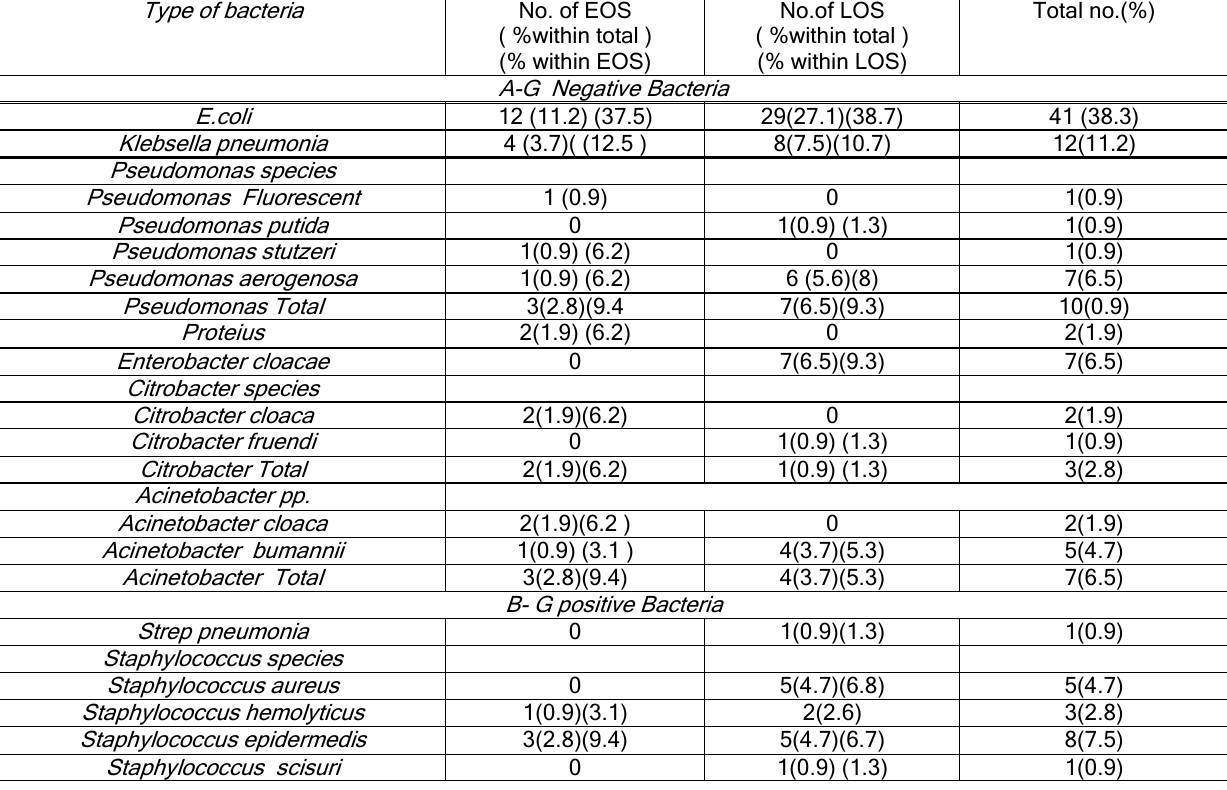
Table 1 : Bacteriological profile of EOS and LOS Type of